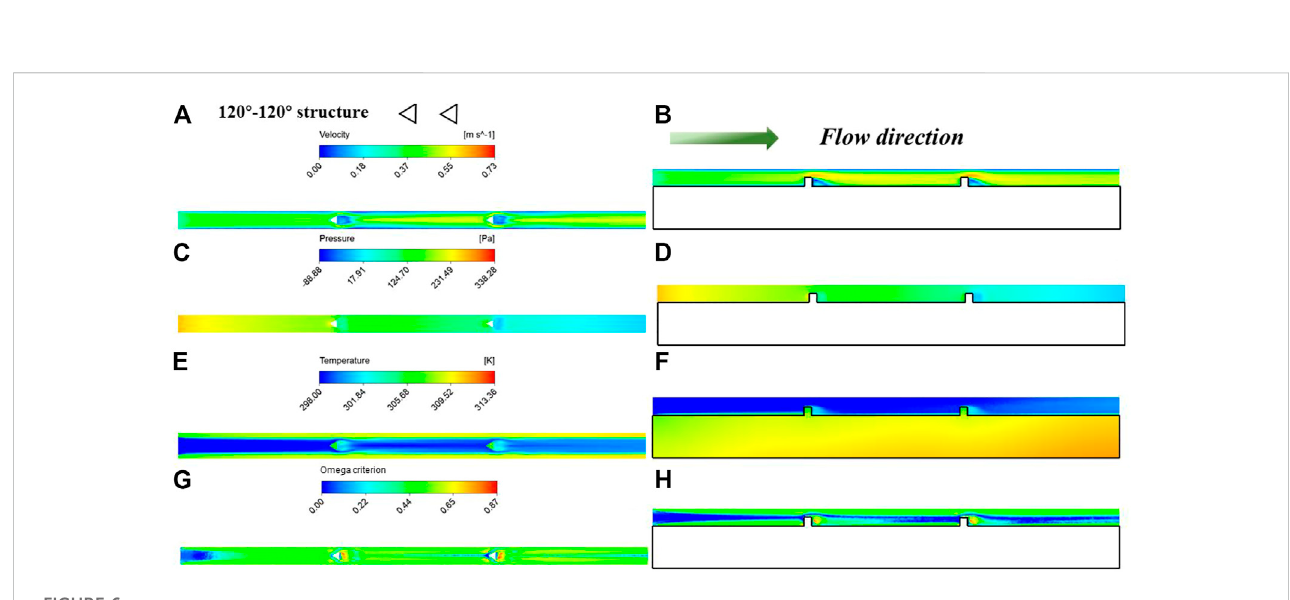
FIGURE 6 Contours of velocity, pressure, temperature and omega criterion values at the planes for the 120 ° – 120 ° structure: (A, C, E, G) for the plane (z = 5.5 mm); (B, D, F, H) for the plane (y = 1.5